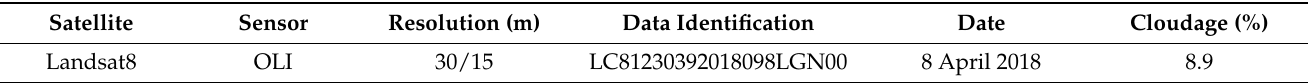
Table 1. Remote sensing picture